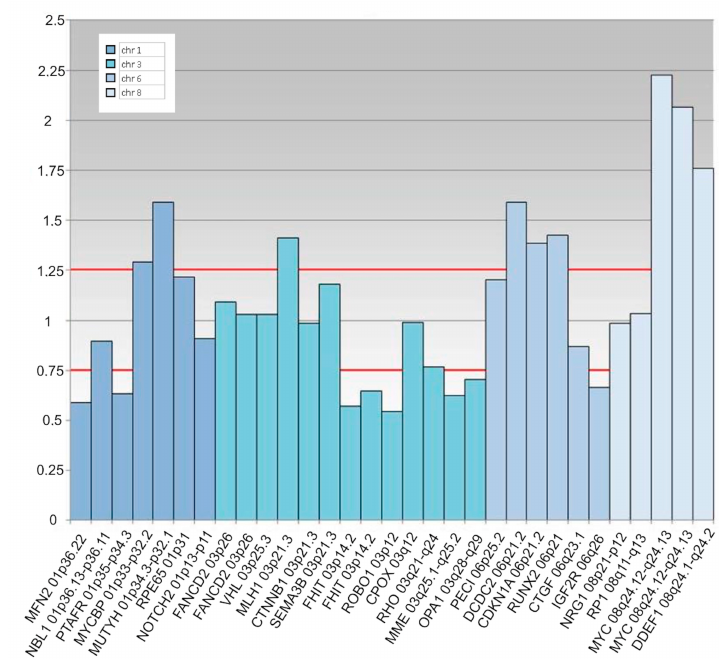
Figure 8. Multiplex Ligation Probe Amplification analysis in a case of posterior uveal melanoma sampled by fine needle aspiration biopsy. The tumor is characterized by losses on the chromosome 1p, 6q and all along the arm of chromosome 3, including the centromeric region until 3p14; gains were also present in the 6p and 8q regions, with an amplification of the MYC gene (8q24.12–8q24.13).